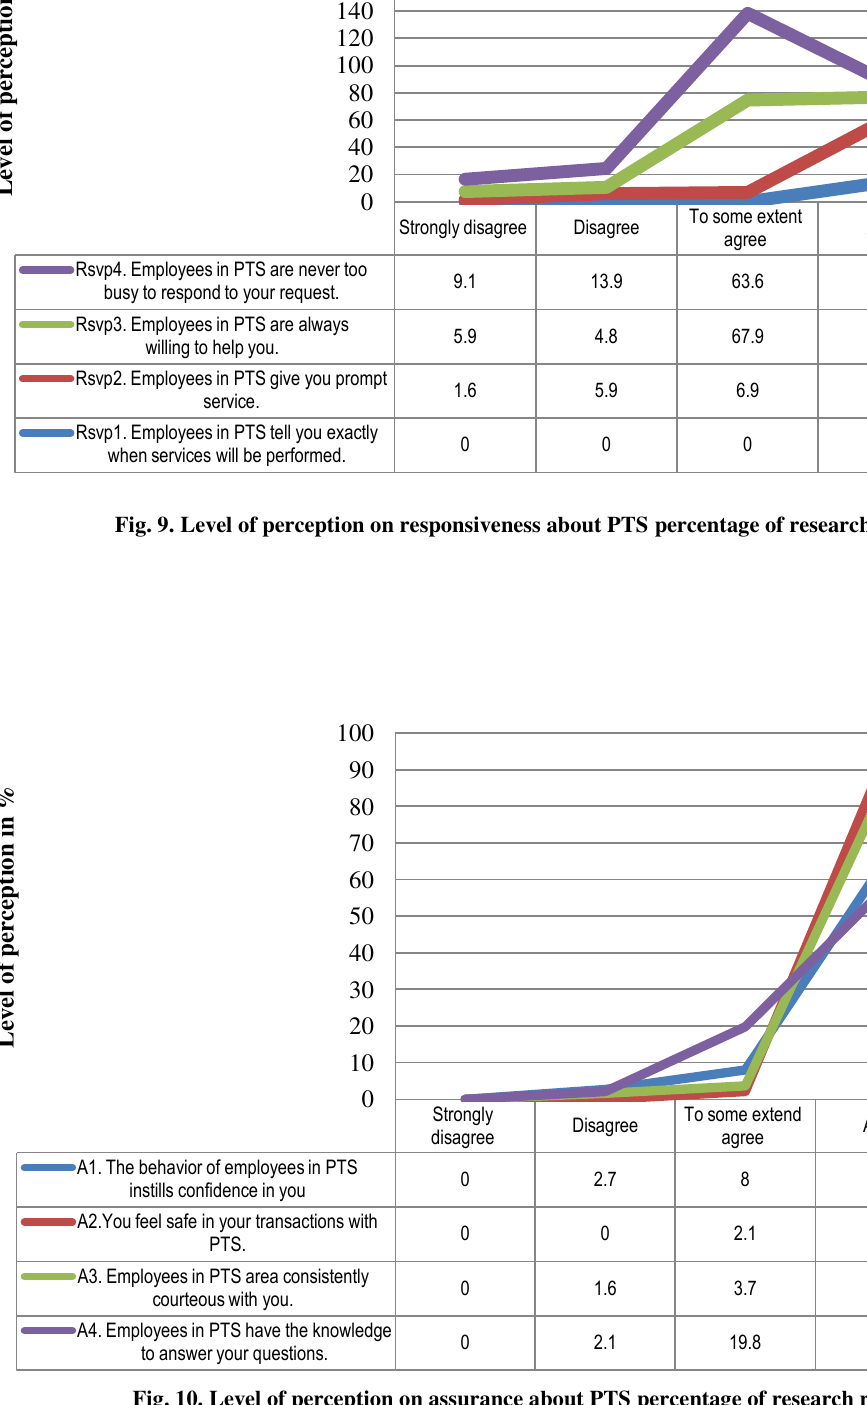
Fig. 10. Level of perception on assurance about PTS percentage of research